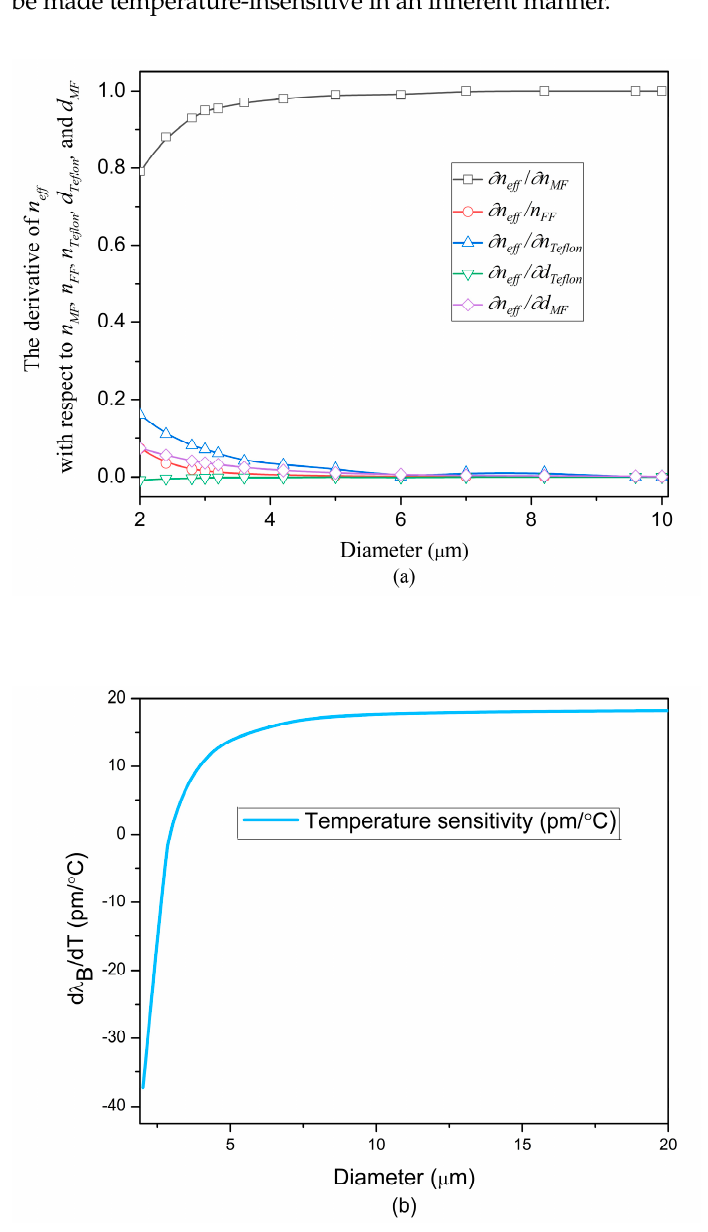
Figure 3. ( a ) The derivative of n ef f with respect to n MF , n FF , n Teflon , d Teflon and d MF for different MF diameters. ( b ) λ B / dT versus different MF